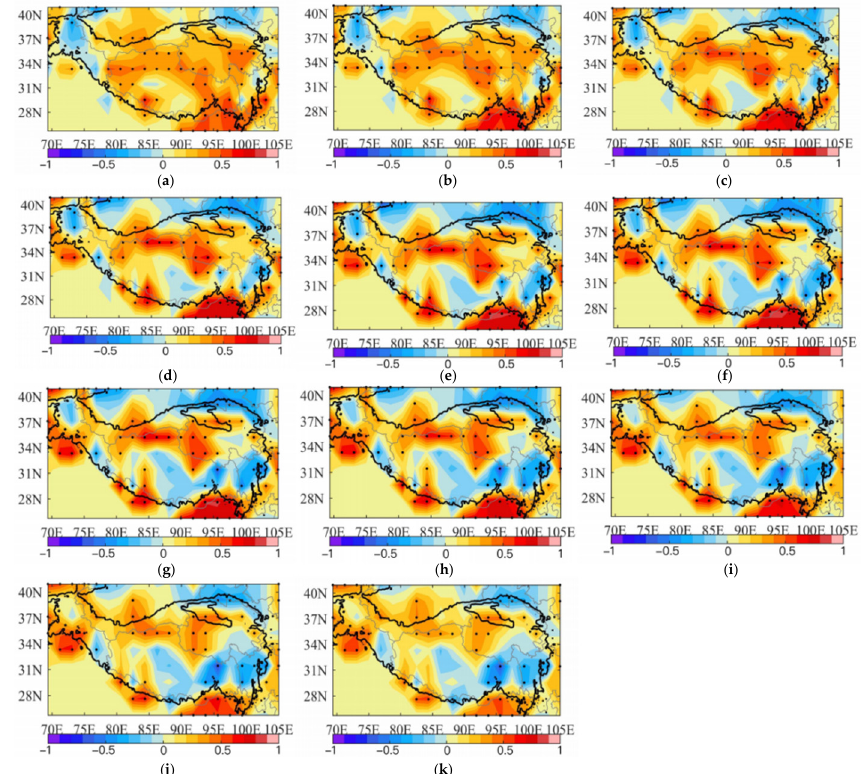
Figure 4. Spatial distribution of the synchronous and lag correlation between winter snow over the QTP and SRF during 1951–2017: ( a ) in the same period; ( b – k ) in the lag of 1–10 years. The black dots represent the grid points that passed the 0.05 significance test.(Units: latitude is ° N , and longitude is ° E.)